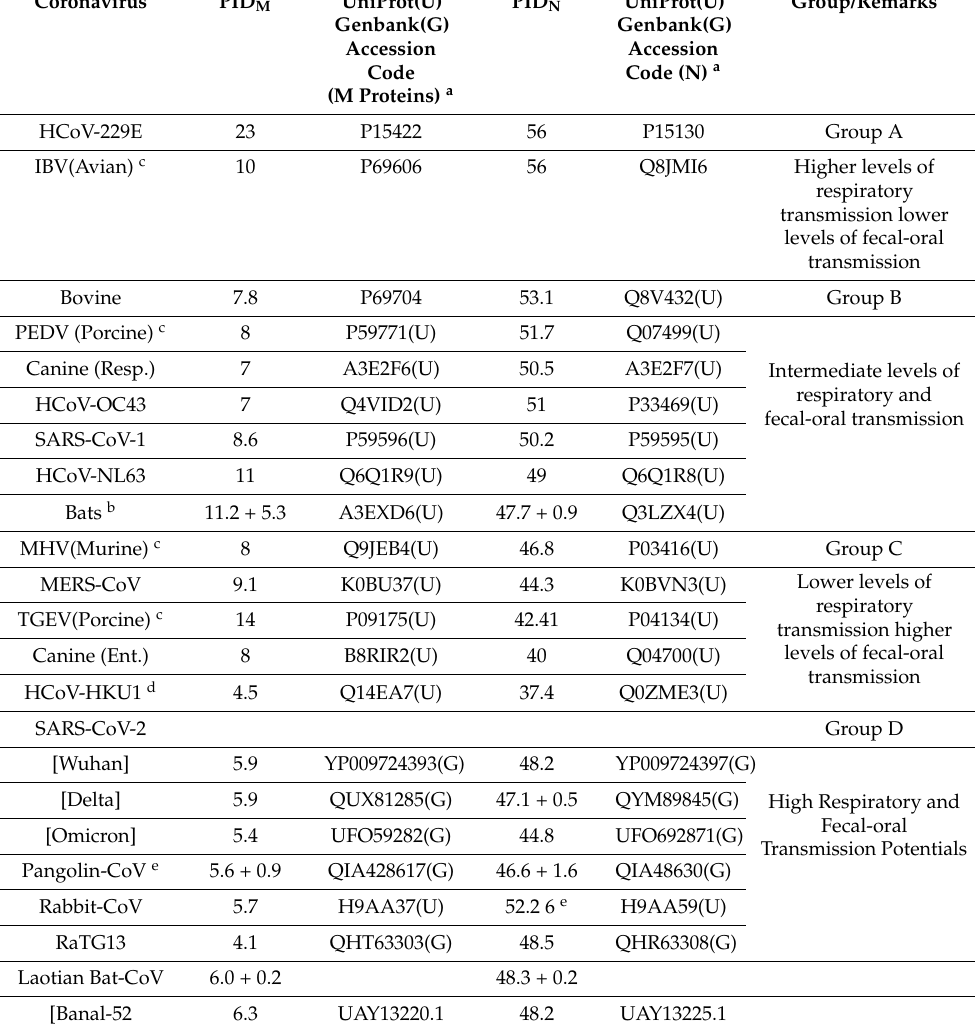
Table 2. Prediction of the Levels of Fecal–Oral and Respiratory Transmission Potentials using PID M and PID N Values as Grouped by Categories. Data pertaining to COVID-19-related bat-CoVs from Laos have been added. (Taken in part from Biomolecules. 2022;12(5). © 2022 Goh et al, Published by MDPI AG, Open access under CC BY-NC-ND license. This is an Open Access article which permits unrestricted non-commercial use, provided the original work is properly cited.